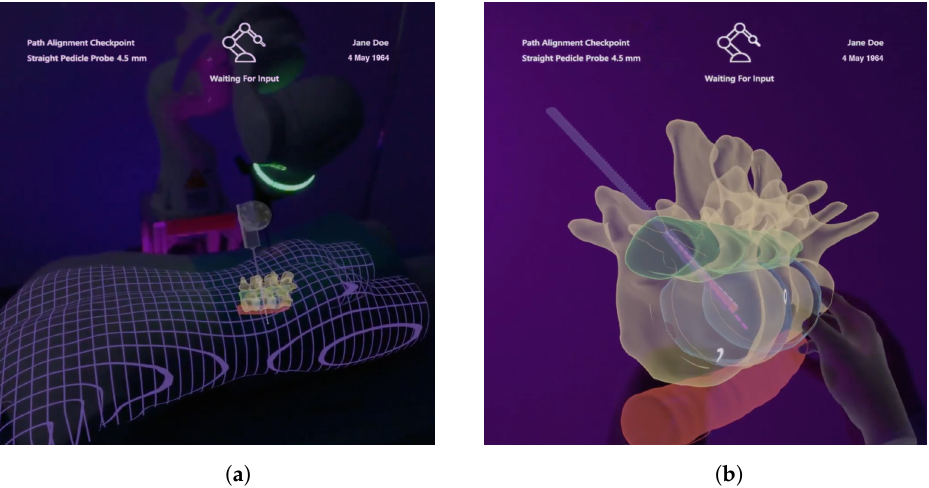
Figure 7. Included 3D models under AR view which contain information about the anatomy of interest, surrounding anatomy, the drill and planning parameters. ( a ) Registered visualization. ( b ) Enlarged virtual